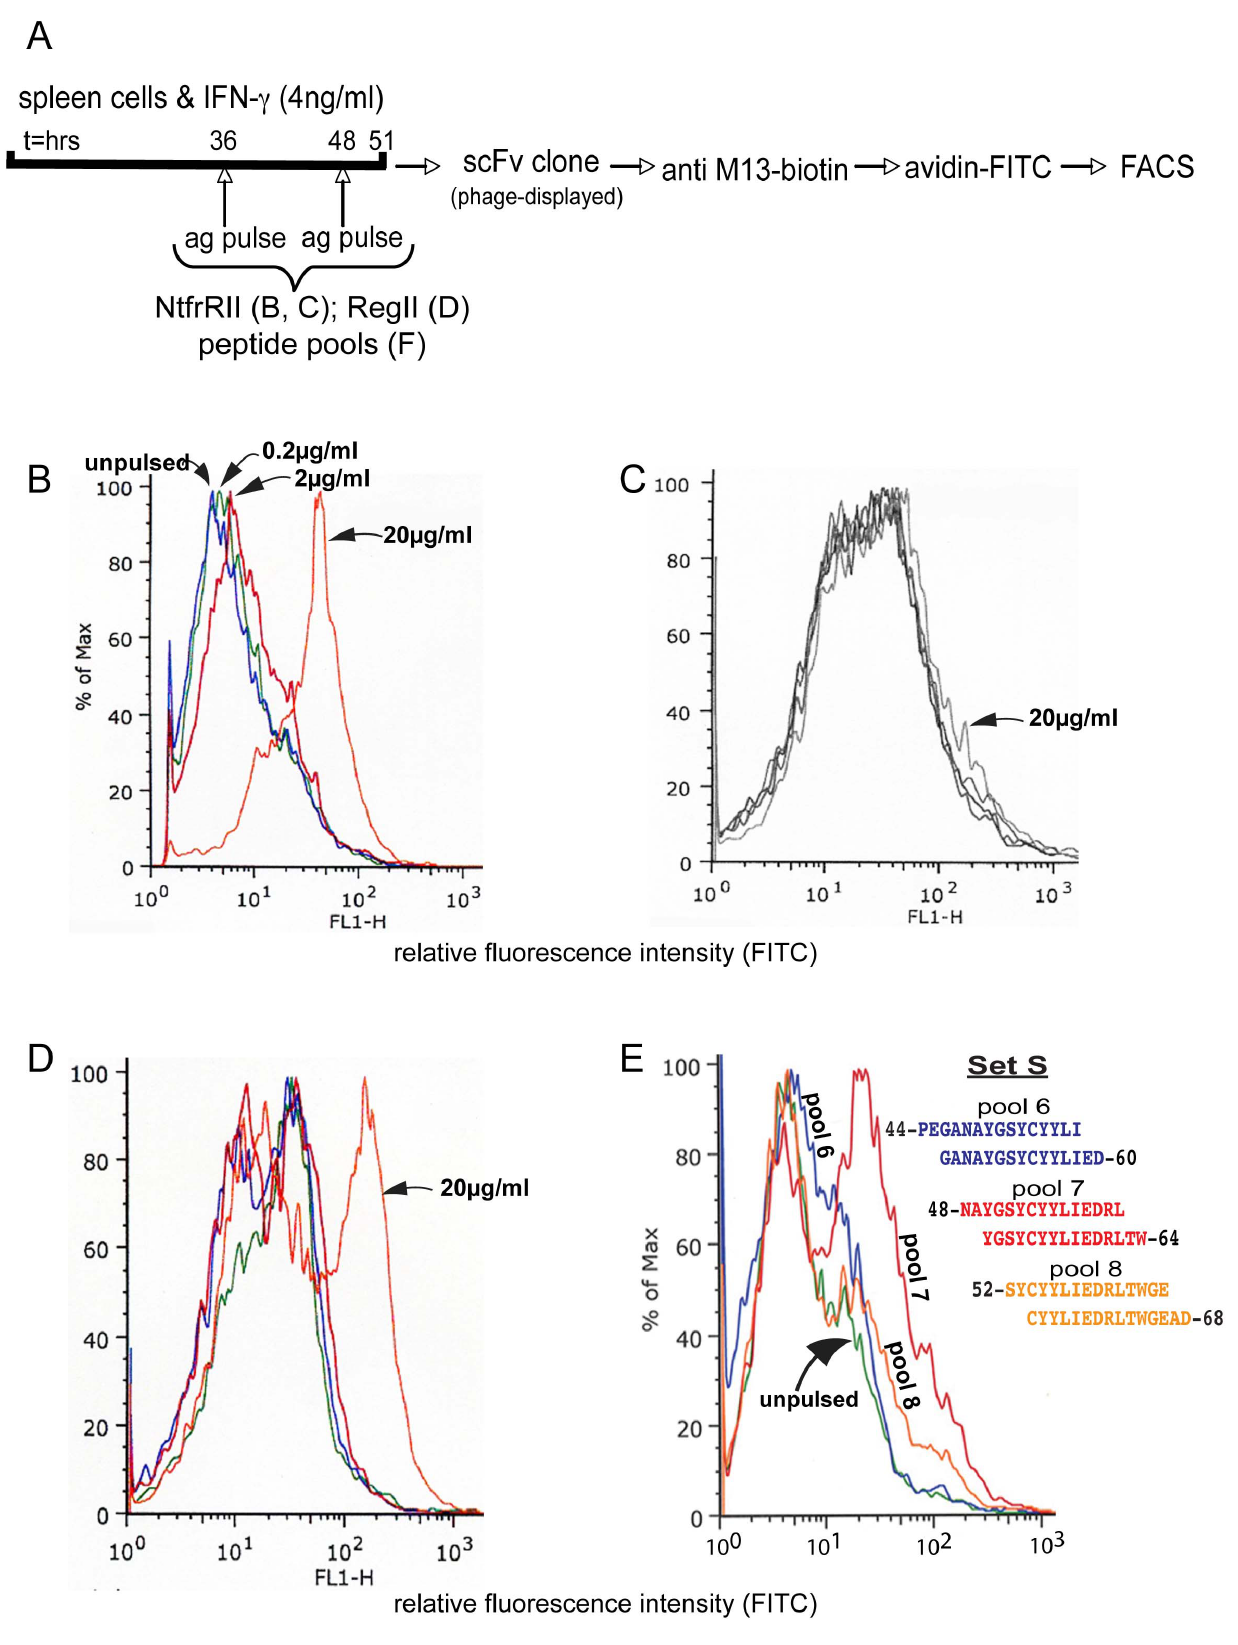
Figure 2. BscFv clone D9, an idiotype that binds I-A g7 NtfrRII peptide complexes and identifies an NtfrRII-derived T-cell epitope. scFv clones were characterized to establish that they represent the desired idiotype. Here the idiotype should recognize an NtfrRII (RegII)-derived